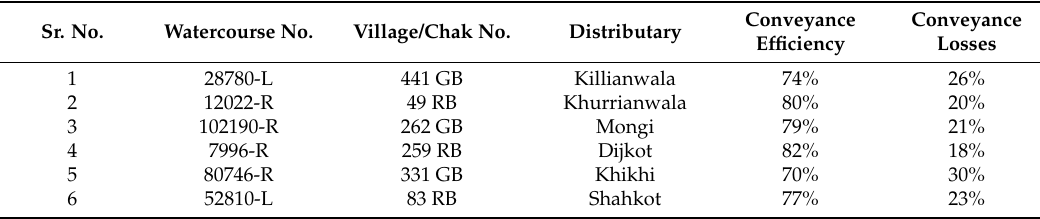
Table 8. Conveyance efficiency and losses of selected watercourses.